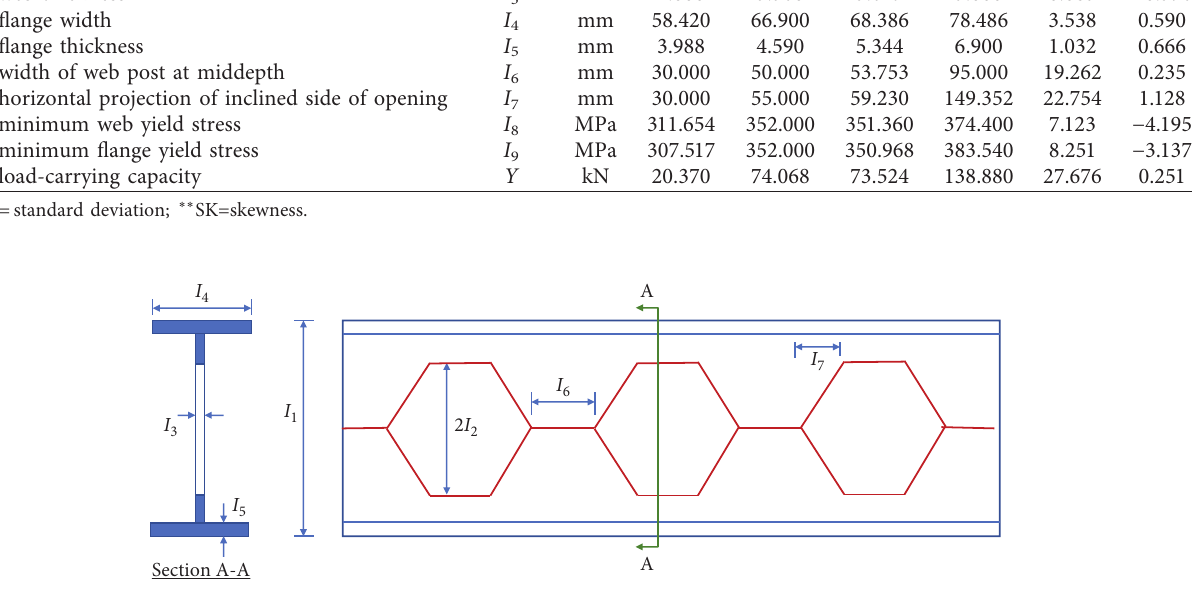
Figure 1: Castellated steel beams and opening geometry.